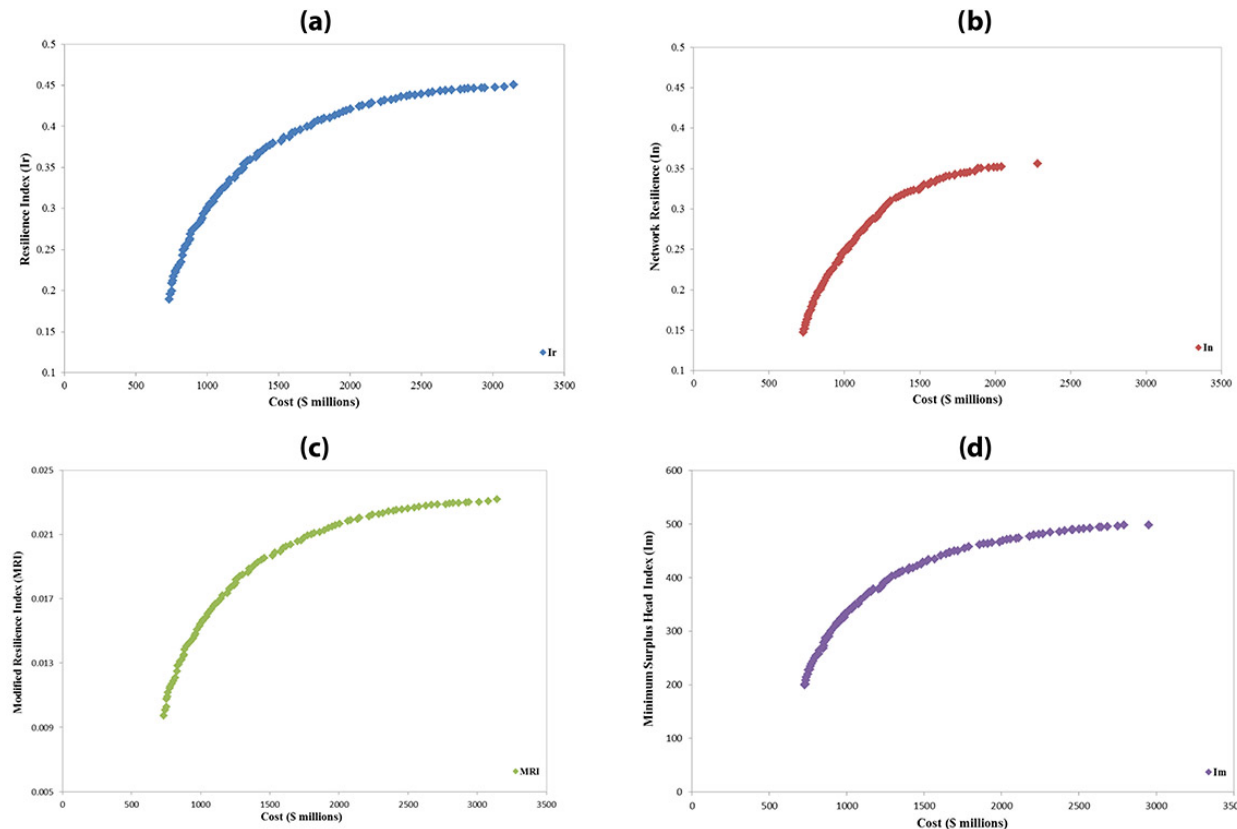
Figure 5. Pareto front of the two-objective function optimization of the real-life network: (a) cost- I r , (b) cost- I n , (c) cost-MRI, and (d) cost- I m .